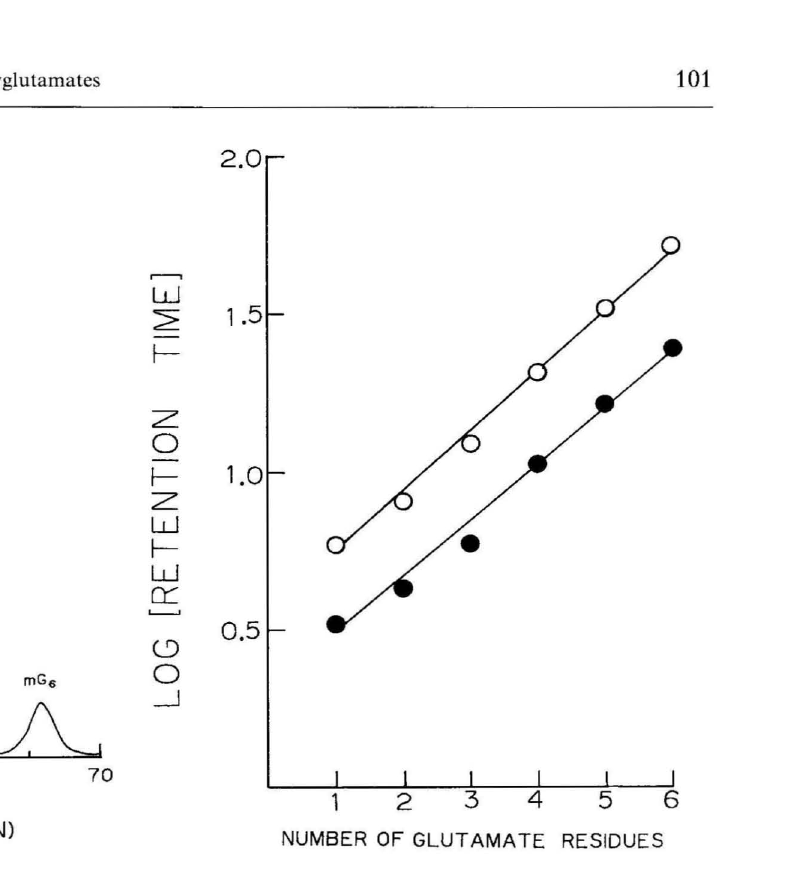
Figure 2. Linearity of retention time with number of glutamat<: residues of H PteGIu n and their 5-methyl derivatives. 4 H 4 PteGlu,_6 (e) and their 5-methyl derivatives (0 ) \\ere chro matographed on a Cosmosil 5-Ph column (50 x 4.6 mm) as described under Material and Methods. and the linearity of retention time versus number of glutamate residues was deter mined.